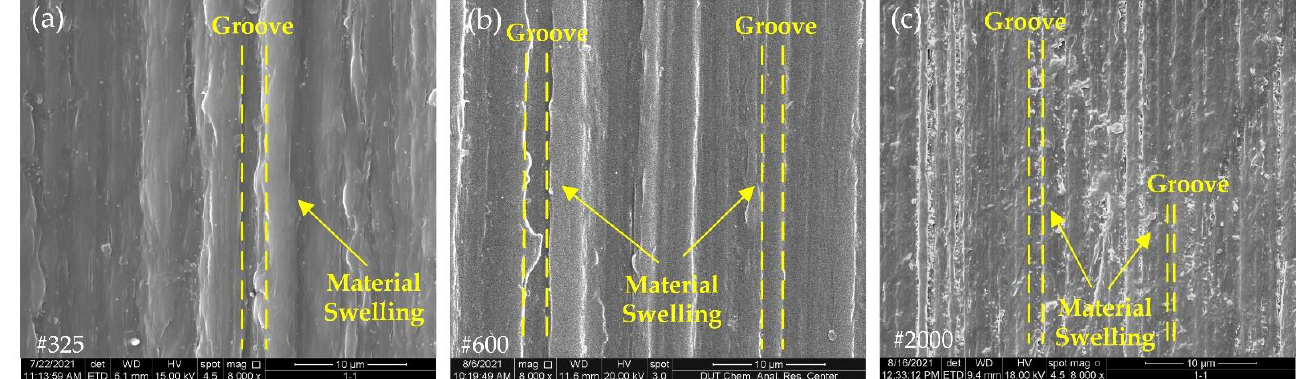
Figure 6. Surface morphology of PEEK with different grinding wheels: ( a ) grit size #325; ( b ) grit size #600; ( c ) grit size #2000.